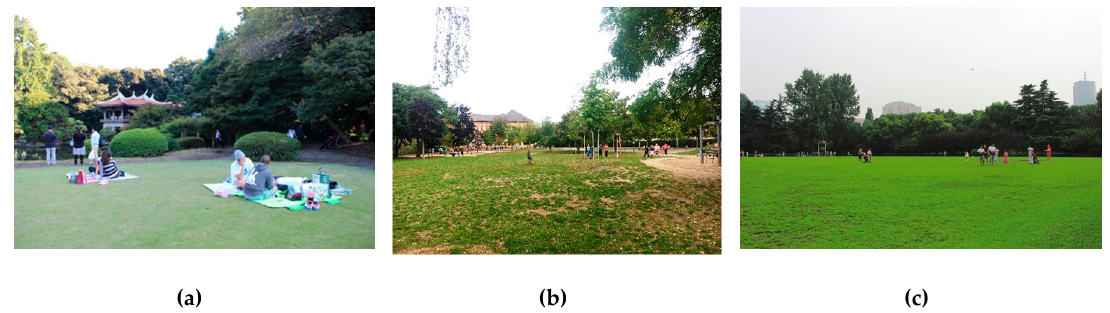
Figure 7. Lawns provide the main arena of human activities in cities today: a ) Park in Tokyo (Japan), ( b ) Rabet Park in Leipzig (Germany), ( c ) Gujiazhai Park in Shanghai (China). Photos: M. Ignatieva, b ) Rabet Park in Leipzig (Germany), c ) Gujiazhai Park in Shanghai (China). Photos: M. Ignatieva, D. D. Dushkova.